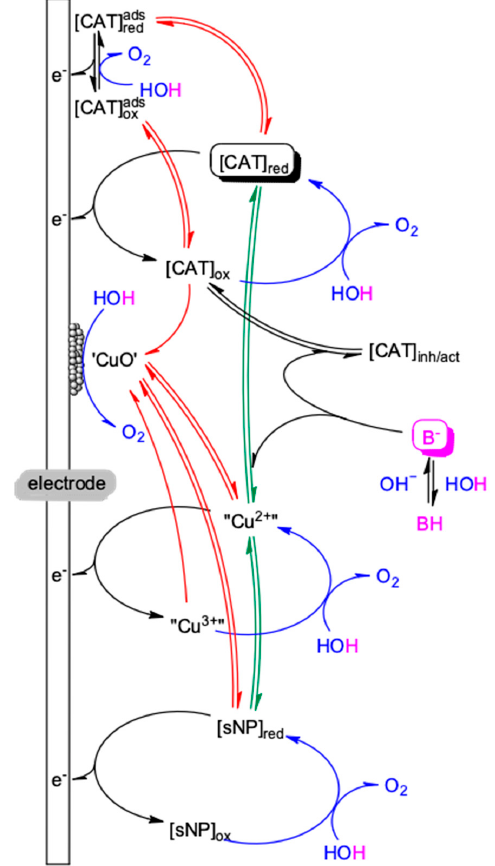
Figure 1. Some representative operando processes that can lead to water oxidation electrocatalysts (WOCs) derived from a primary molecular system.